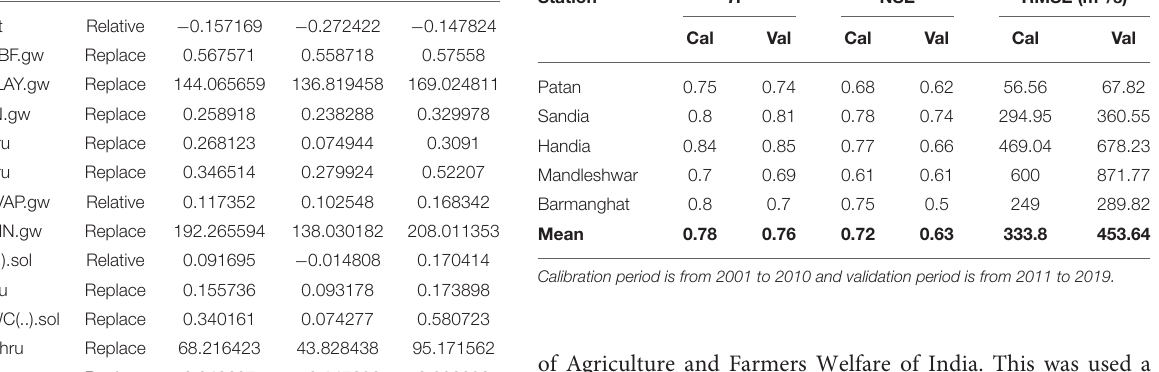
TABLE 5 | Performance of the SWAT model for streamflow calibration and validation at the five calibration sites.